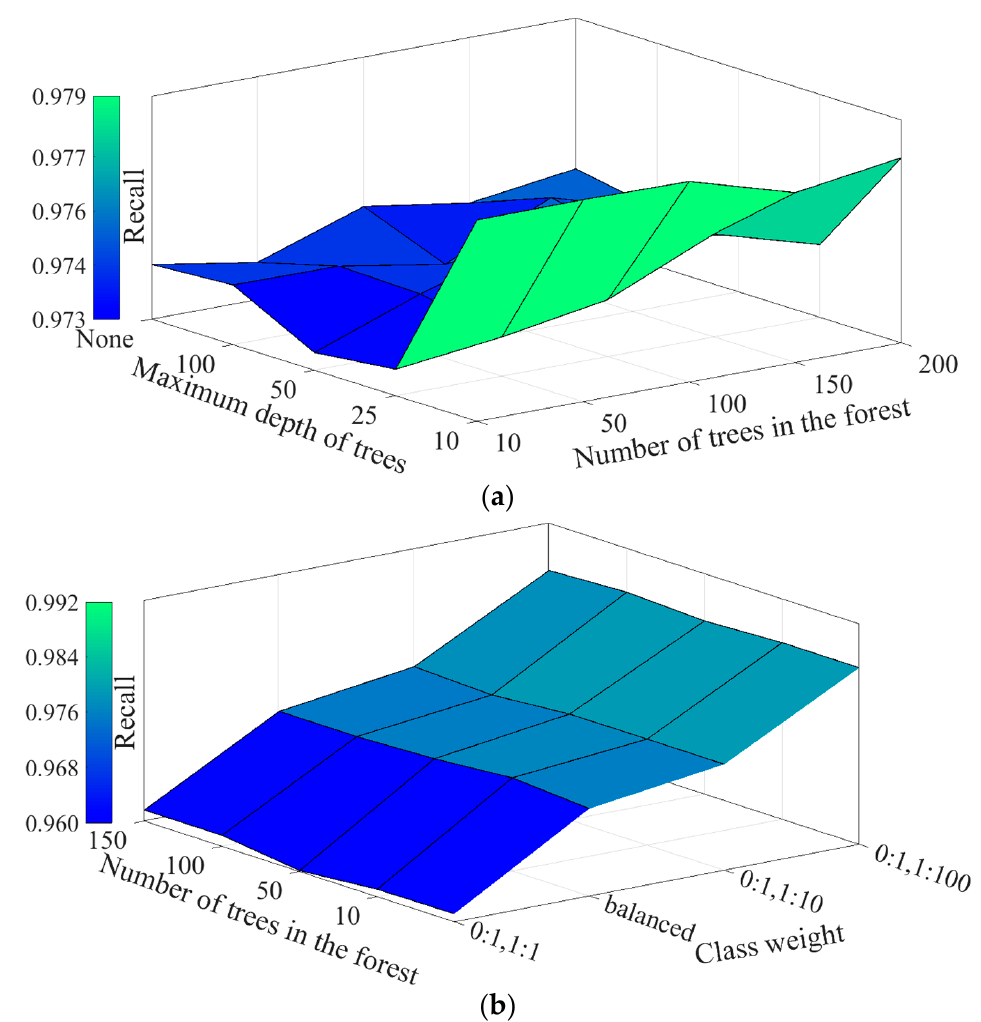
Figure 8. The change in the Recall value for different values of MDT and NTF ( a ), as well as for the different values of class weights and NTF ( b ).